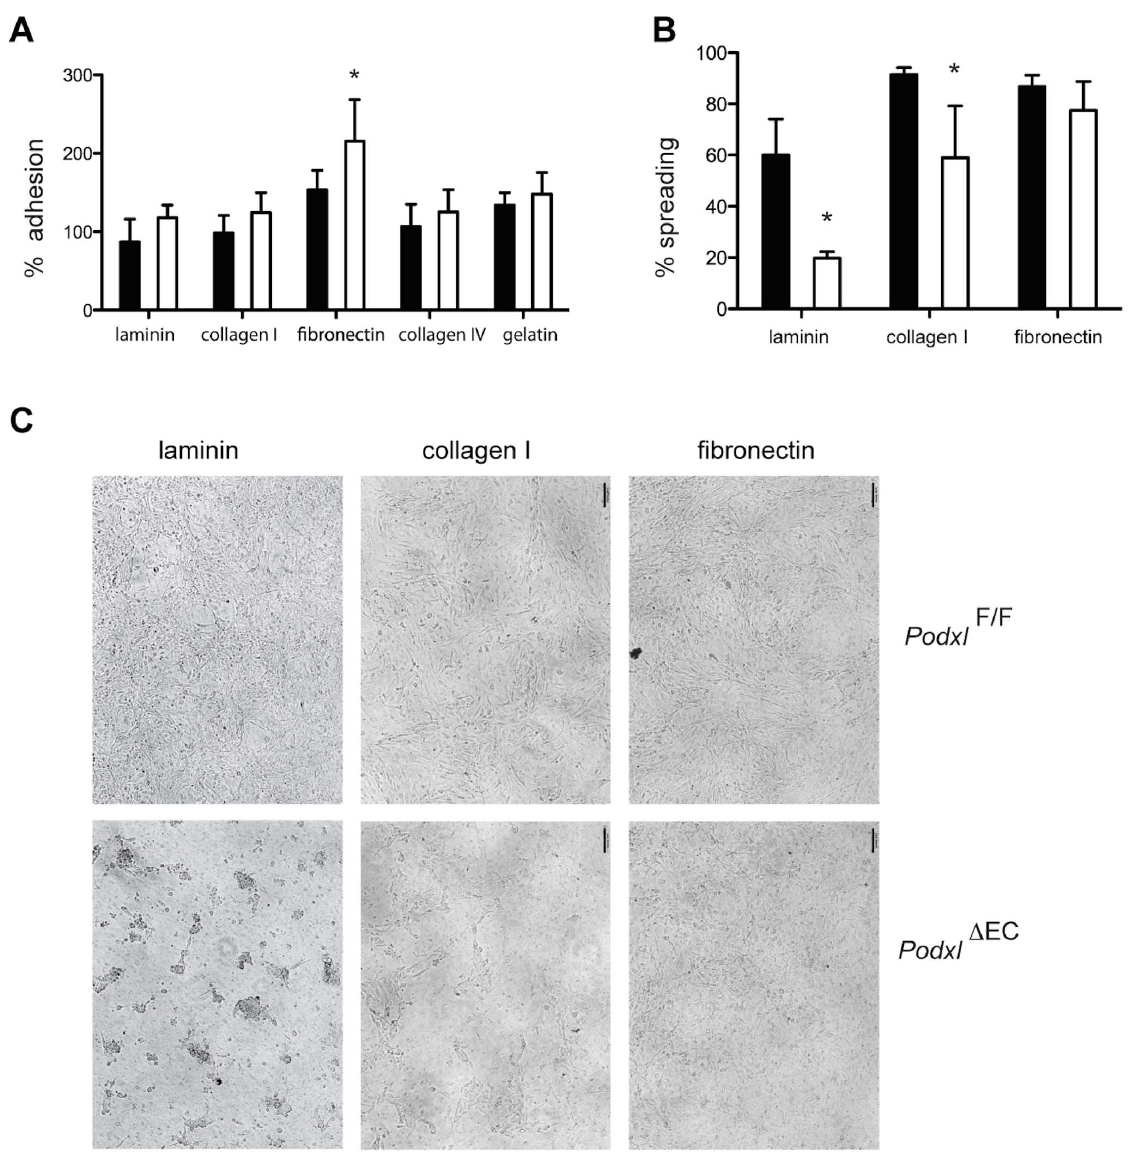
Figure 8. Podocalyxin expression on lung endothelial cells is required for efficient spreading on laminin and collagen I matrices. ( A ) Static adhesion of lung mECs isolated from Podxl F/F (black bars) and Podxl D EC (white bars) mice to surfaces coated with fibronectin, laminin, gelatin, collagen I, and collagen IV. Primary mEC were plated on matrix-coated plates for 90 min, washed and adhesion quantified by crystal violet absorbance. The average absorbance for the uncoated wells was normalized to 1 and the relative absorbance (proportional to adhesion) is shown. ( B ) Spreading of lung mECs isolated from Podxl F/F (black bars) and Podxl D EC (white bars) mice. Primary mECs were plated on matrix-coated transwells (0.4 m m pore size) and cultured for 48 h. The % monolayer coverage (spreading) was assessed by the threshold area of the cell monolayer via ImageJ on at least 3 independent cultures per genotype. The mean adhesion reported here was pooled from two independent experiments. ( C ) Representative bright field micrographs of spreading assay described in (E). Error bars = SEM, *Significantly different with P , 0.05 by Student’s t test or one-sample.